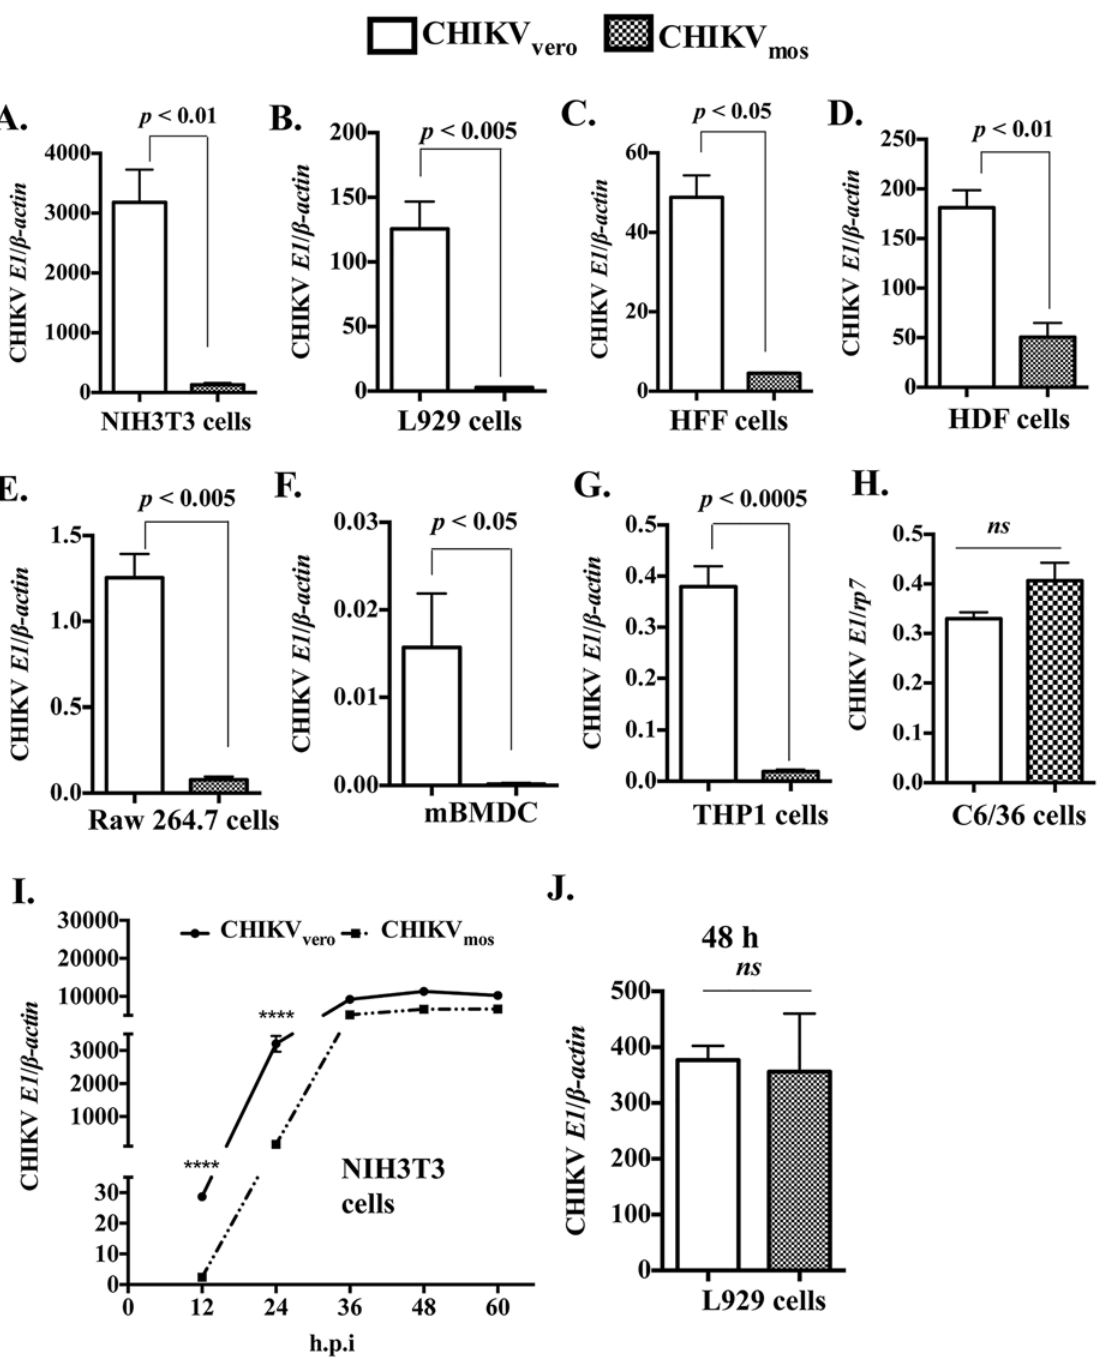
Fig 1. CHIKV mos has reduced infectivity than CHIKV vero . (A-H) Indicated cells were infected with CHIKV vero or CHIKV mos (Ross strain, MOI = 1) for 24 h to measure gene expression of CHIKV E1 and cellular β -actin by RT-qPCR. (I) NIH3T3 cells were infected with CHIKV vero and CHIKV mos (Ross strain, MOI = 1) for 60 h and CHIKV E1 expression was measured at indicated time points by RT-qPCR. (J) L929 cells were infected with CHIKV vero or CHIKV mos (Ross strain, MOI = 1) for 48 h to measure gene expression of CHIKV E1 by RT-qPCR. Results were shown as the ratio (mean ± SEM) copy number of CHIKV E1 to cellular β -actin . Ribosomal protein 7 (rp7 ) was used as a housekeeping gene control for C6/36 cells. All data represent at least two independent experiments performed in triplicates with similar results. Replication between CHIKV vero and CHIKV mos were compared using student ’ s t test ( **** denotes p < 0.0001, and ns denotes p (cid:1)